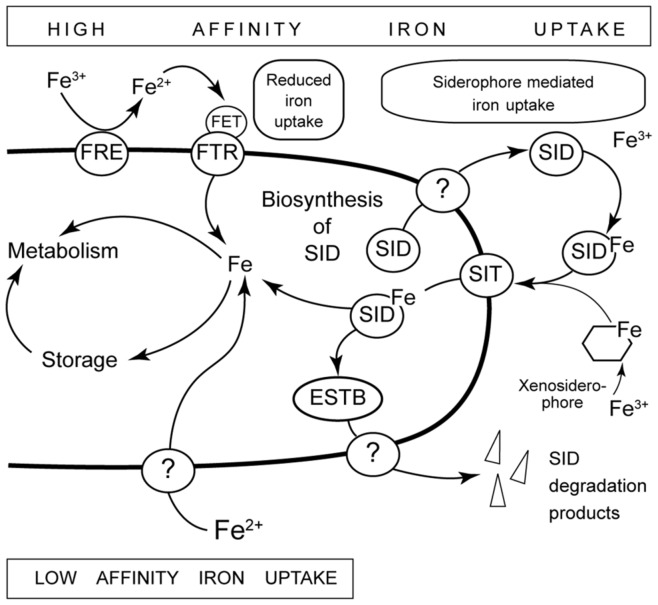
High and low affinity uptake of iron in filamentous fungi.Under iron limiting conditions two high affinity iron import mechanisms are involved in uptake of iron from the environment. Via the reductive iron assimilation (RIA) system, ferric iron first becomes reduced to ferrous iron by a reductase (FRE) and then oxidized by a multicopper oxidase (FET) and imported by a plasma membrane transporter (FTR). Many fungi also produce and secrete siderophores (SID) and, after binding of iron (SID Fe) are reimported into the cell. Bound iron is subsequently made accessible to the cell by activity of a specific esterase (ESTB). In S. cerevisiae is only able to take up siderophores (Xenosiderophores) that available in the environment.